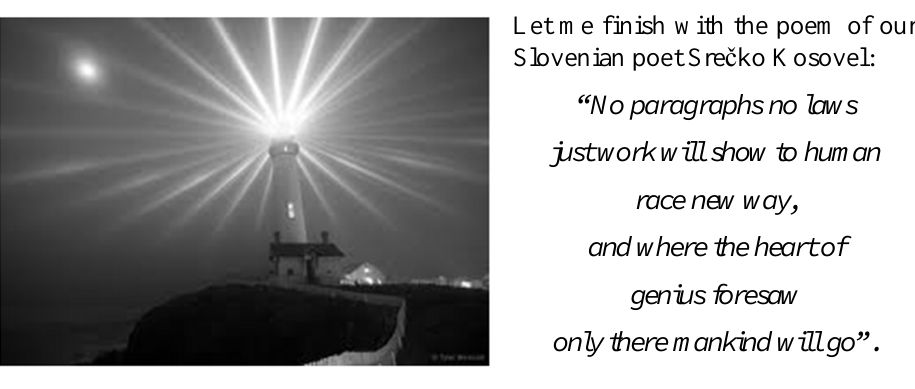
Figure 1 – Humanity needs examples of excellence as lighthouses for all others who would like to